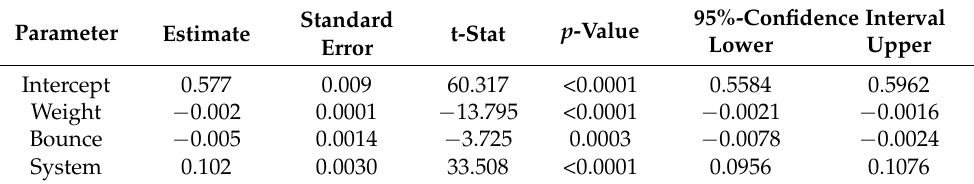
Table 6. Estimated values of the regression Model II parameters ( α =